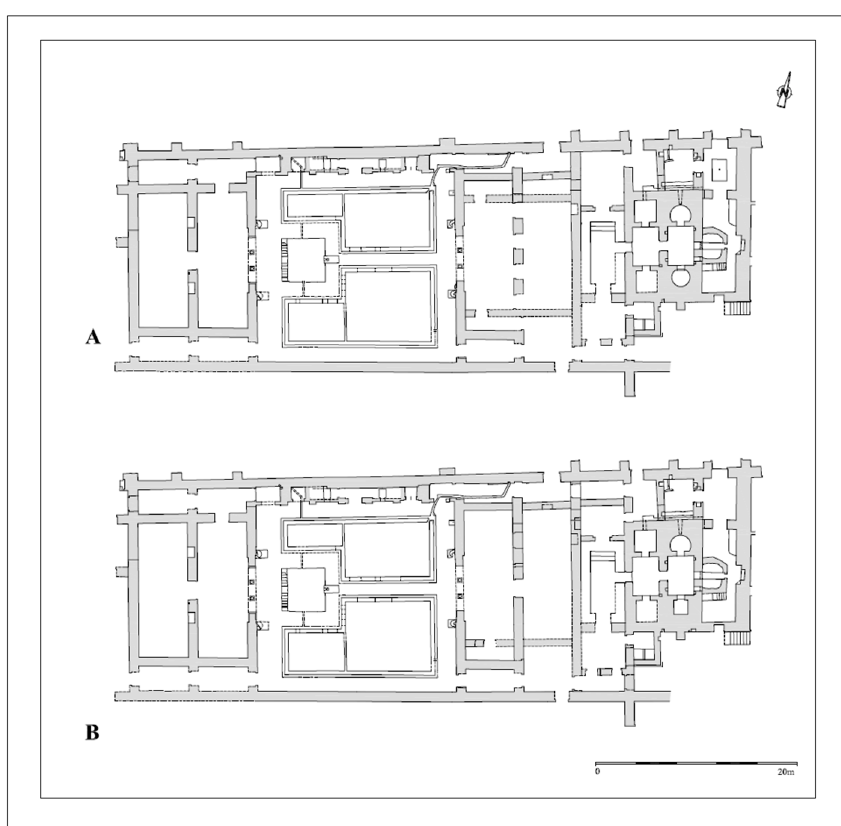
Figure 7. Construction phases of House of the Pool: ( A ) first phase; ( B ) second phase (Vallejo Triano 2010, Figure 53-2).